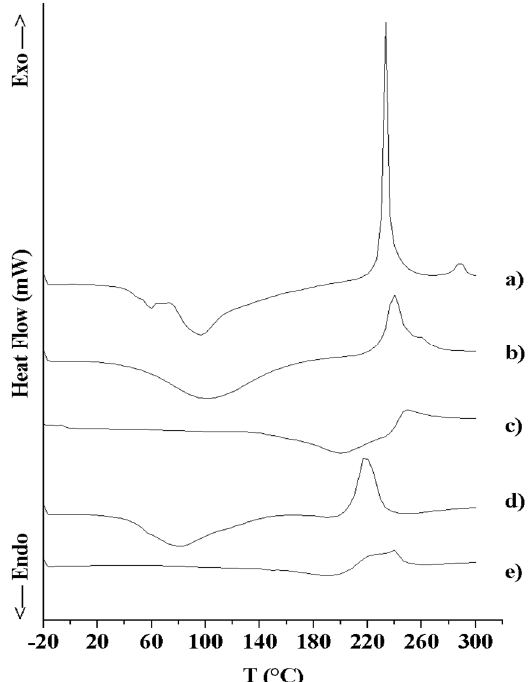
Figure 5. DSC thermal profiles of: SAP (a), HA MS (b), HA-CL MS (c), HA–SAP MS (d), HA-CL–SAP MS (e).